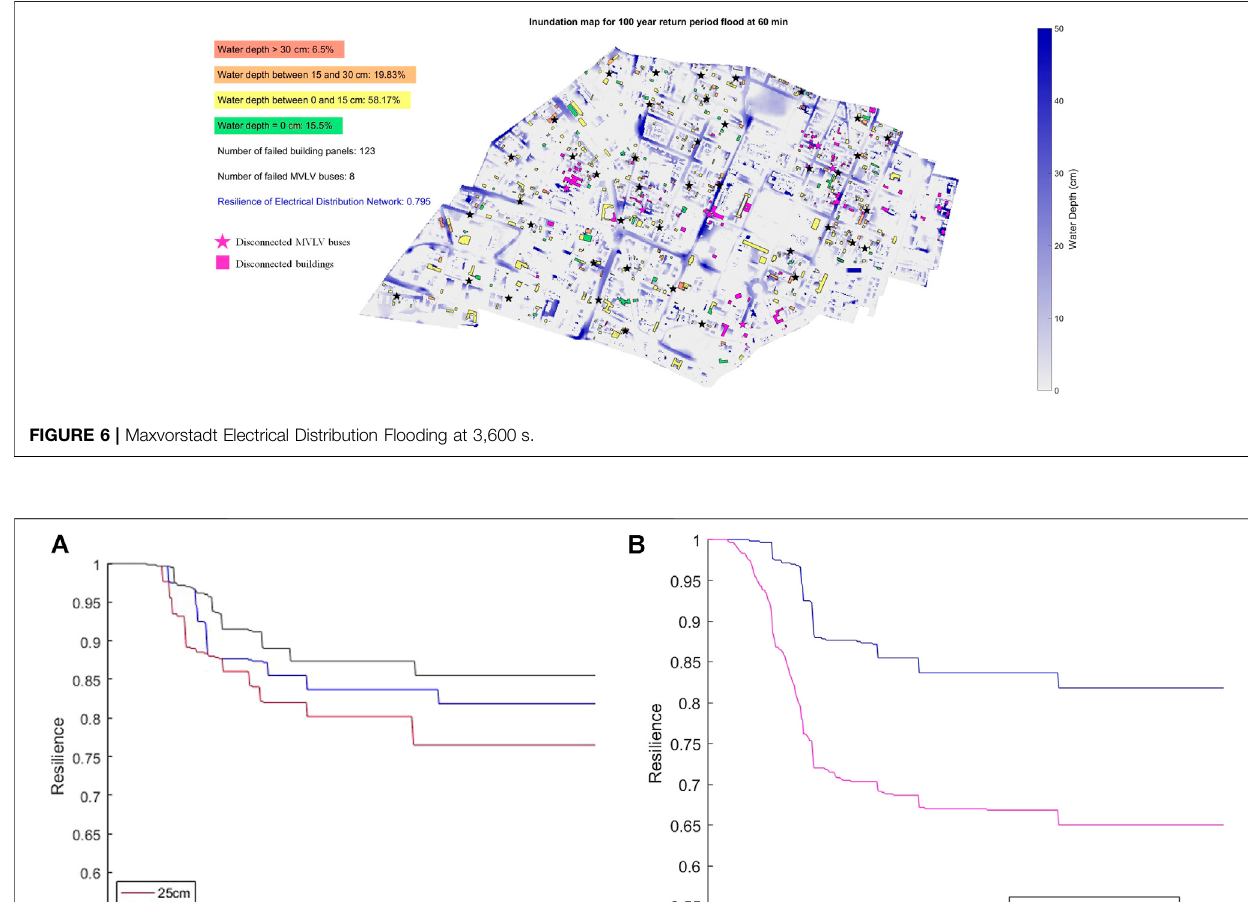
Frontiers in Earth Science |